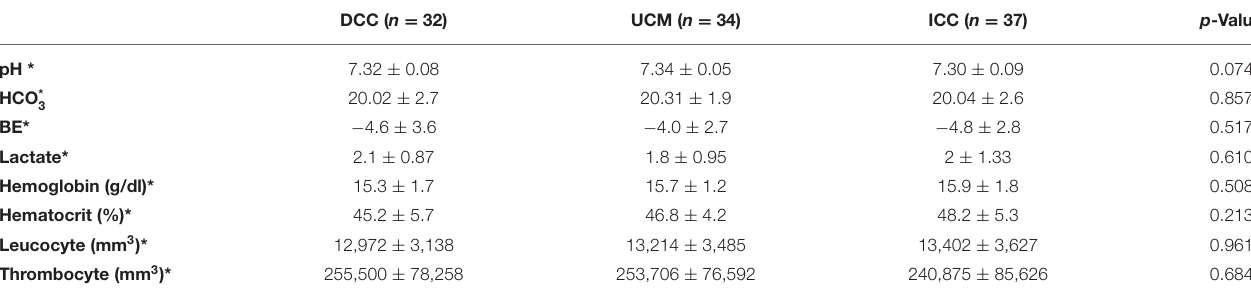
TABLE 3 | Blood gas values and hematological